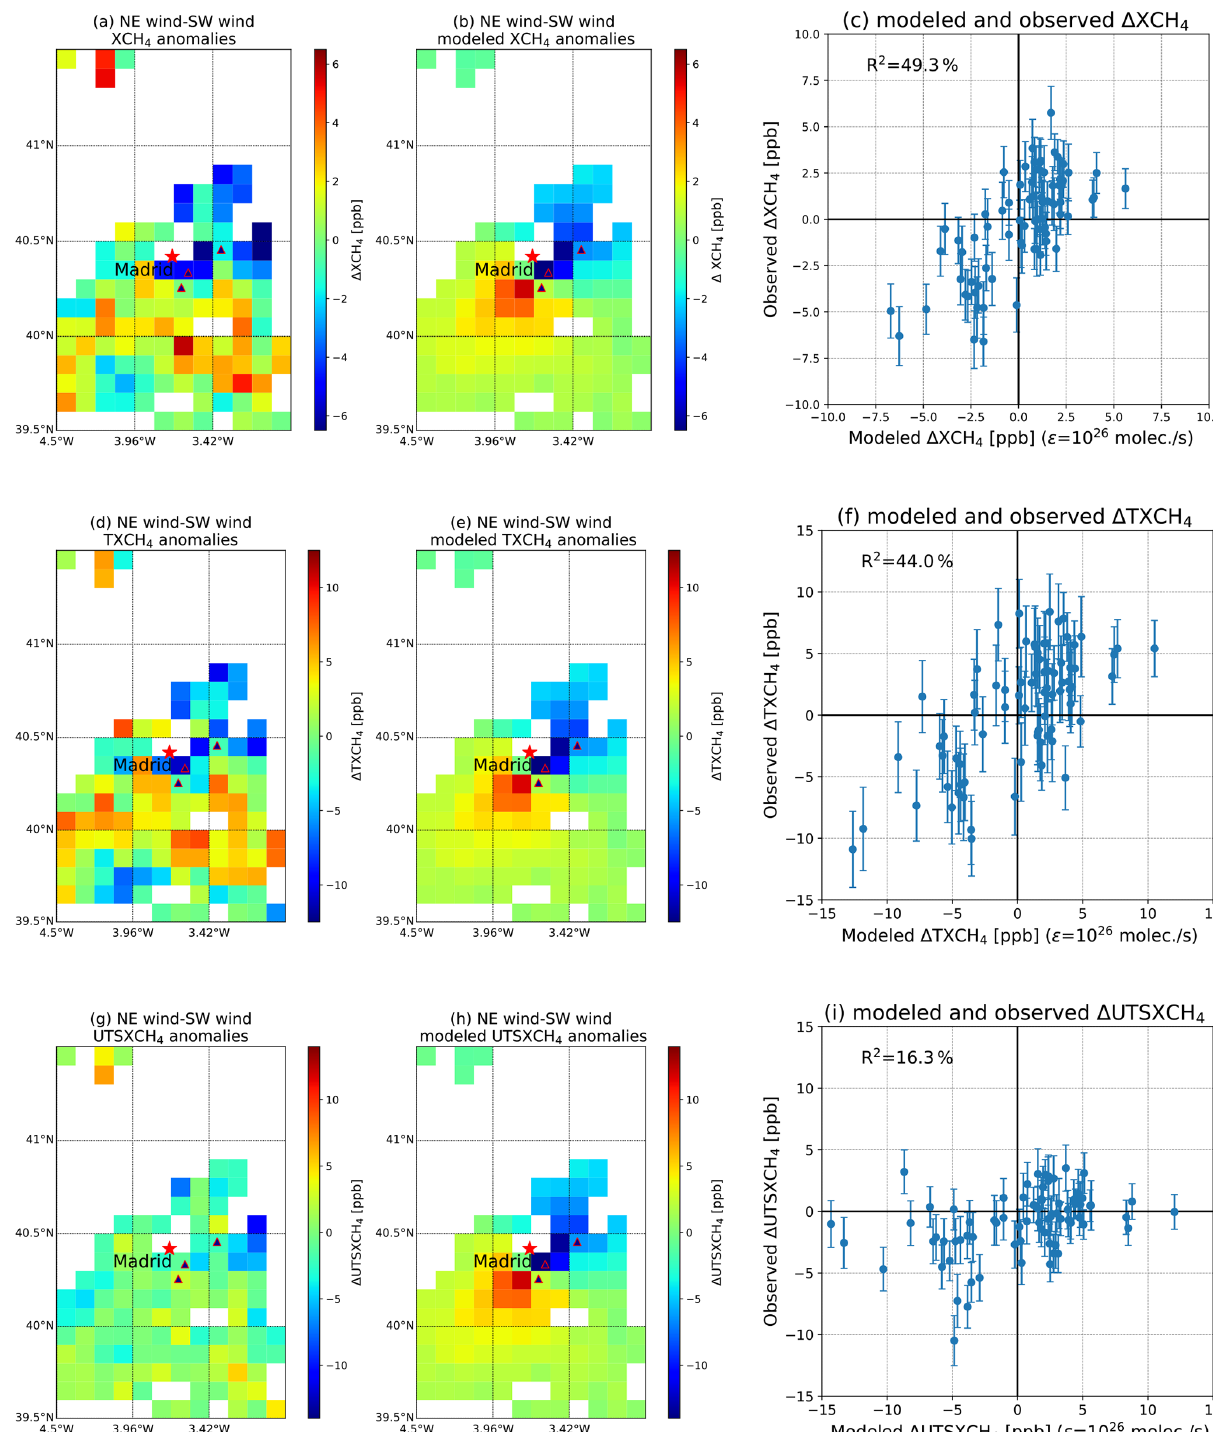
Figure 9. Wind-assigned XCH 4 plume derived from (a) TROPOMI XCH 4 anomalies, (d) synergetic TXCH 4 anomalies, and (g) UTSXCH 4 anomalies and their corresponding modeled plume (b, e, h) over Madrid in the NE–SW direction on a 0.1 ◦ × 0.135 ◦ latitude–longitude grid. The correlation plots between observed (cid:49) XCH 4 and modeled (cid:49) XCH 4 ( ε = 1 × 10 26 molec.s − 1 ) for different products (c, f, i) . Here we use the three waste plants as the point sources (blue triangle with red edge color). The initial emission rate in the plume model is 1 × 10 26 molec.s − 1 . This value is proportionally distributed into three point sources based on the a priori knowledge of emission rate in each waste plant. For the modeled UTSXCH 4 anomalies we assume the CH 4 enhancements to occur at altitudes between 7 and